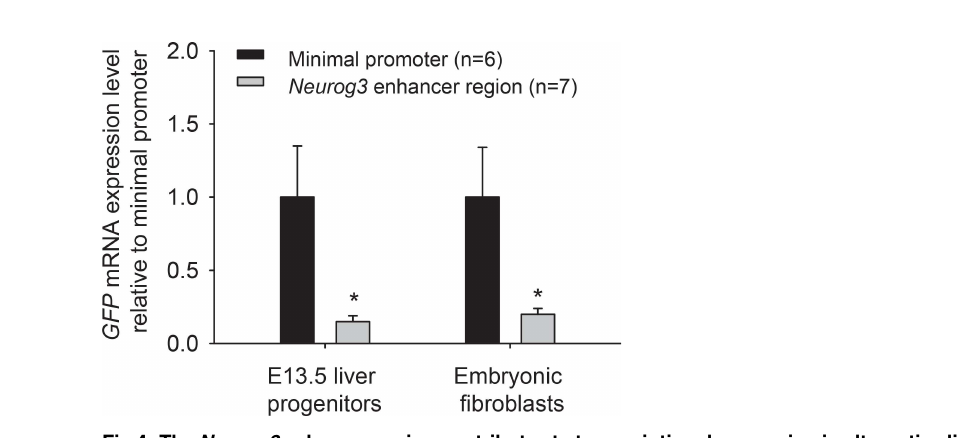
Fig 4. The Neurog3 enhancer region contributes to transcriptional repression in alternative lineages. qRT-PCR analysisshowedthat in E13.5 liver progenitors and embryonic fibroblasts from transgenicscarrying the Neurog3enhancer, GFP mRNA was significantly reduced. GFP transcript levels were normalizedfor Tbp and comparedto the construct that lacked the Neurog3enhancerregion([ * ] ( P < 0.05,Student’st-test).